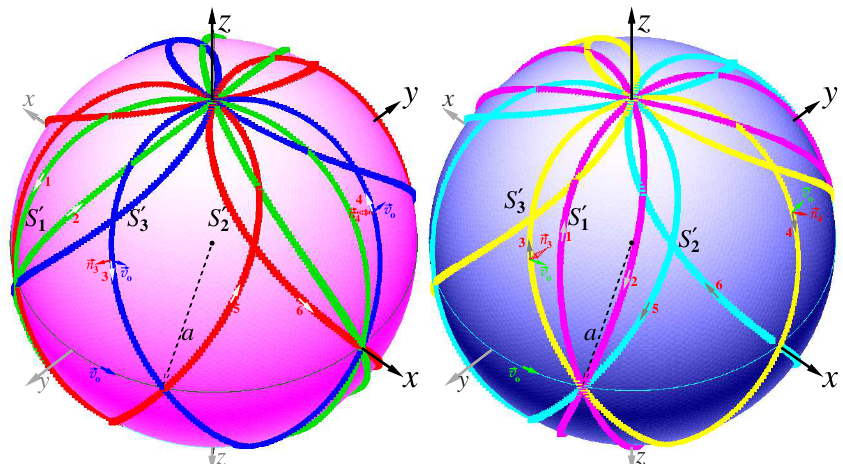
Figure 13. Three strings superimposed on the sphere of the radius a = 1 shown from the left are as follows: S (cid:48) (colored in green) has parameters ω 1 = 1/3, φ 1 = 0; S (cid:48) (colored in red) has parameters 2 1 ω 1 = 2/3, φ 1 = π ; S (cid:48) (colored in blue) has parameters ω 1 = 2/3, φ 1 = 0. The other parameters 3 for all strings are ω 0 = 1, φ 0 = 0. White arrows, numbered by 1, 2, 3, 4, 5, 6, mark the current flowing along strings. Blue arrows point the direction of the orbital velocity (cid:126) v o . For the currents 3 and 4 orientation of the normals is shown—the normal (cid:126) n 3 is oriented to outside (red arrow) and (cid:126) n 4 inside (punctuated red arrow). The right figure represents the CPT transformation of ensemble of the left